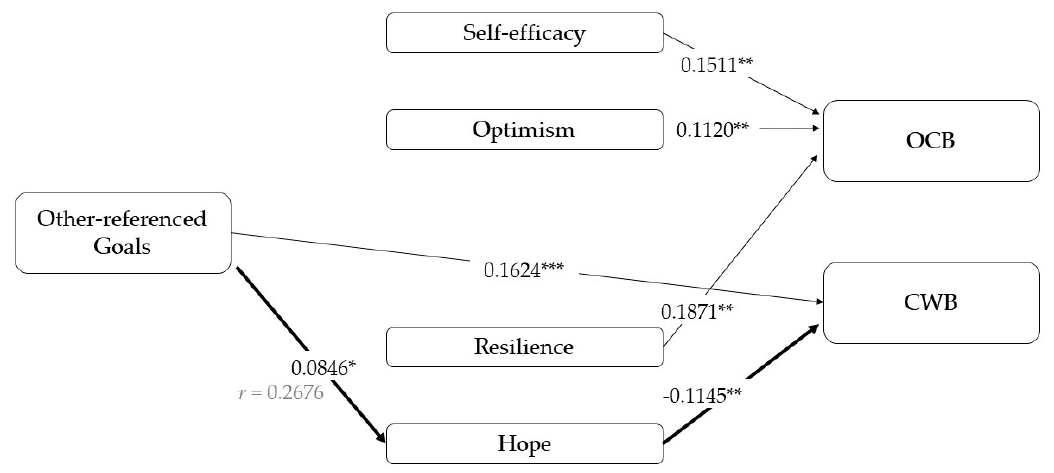
Figure 4. Results of the mediation models with other-referenced goals as an independent variable.